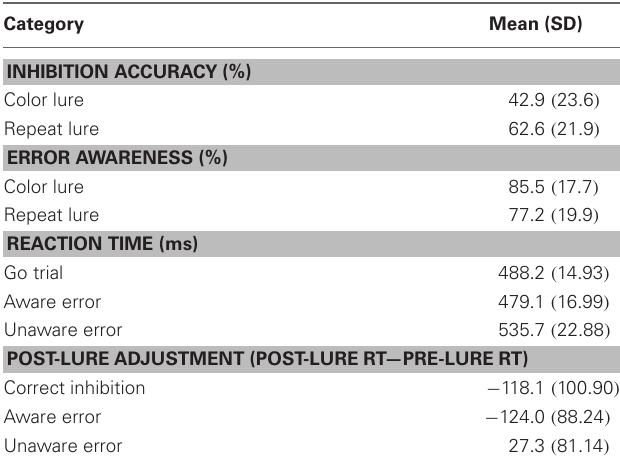
Table 1 | Behavioral performance: inhibition accuracy and reaction time on the